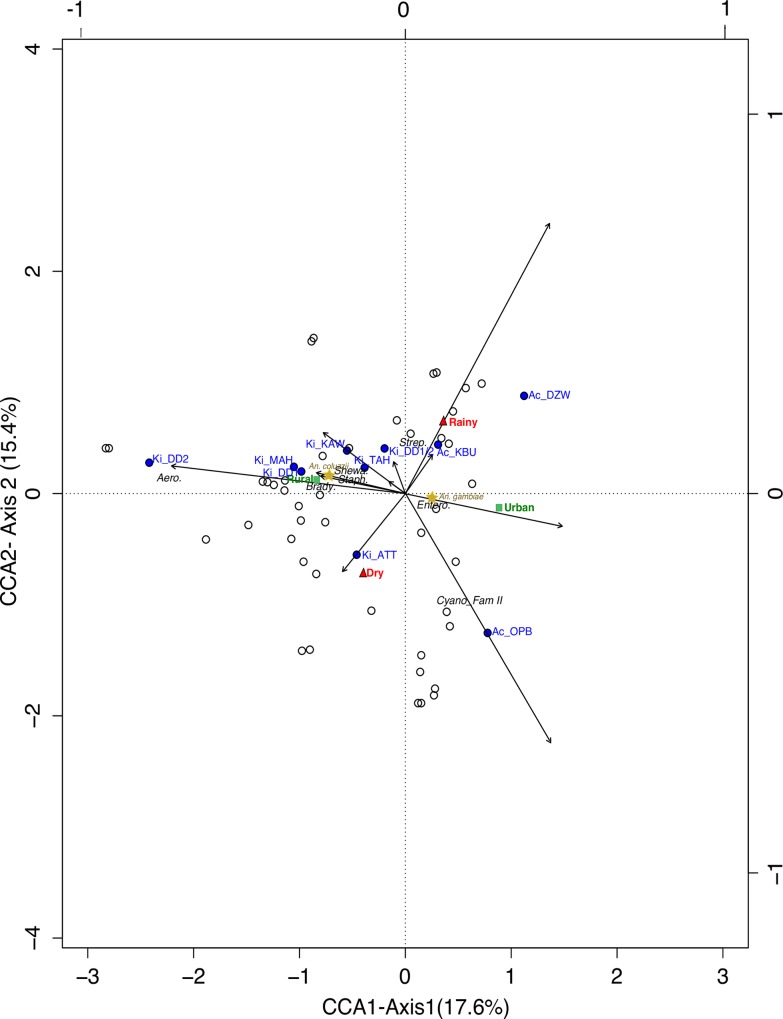
Canonical Correspondence Analysis (CCA) for microbiota composition between breeding sites in the dry and rainy season.Filled circles represent breeding sites and hollow circles represent samples (taxonomic level = family). Bacterial families with ≥0.01 relative abundance are indicated by name. Filled squares, triangles and stars represent site status (rural, urban), sampling season (dry, rainy), and mosquito species respectively. The length of each arrow indicates the strength of the variable that explains the bacteria dispersion observed. Bottom x-axis and left y-axis are scales for factors plotted, while top x-axis and right y-axis are scales for the biplot (arrows).